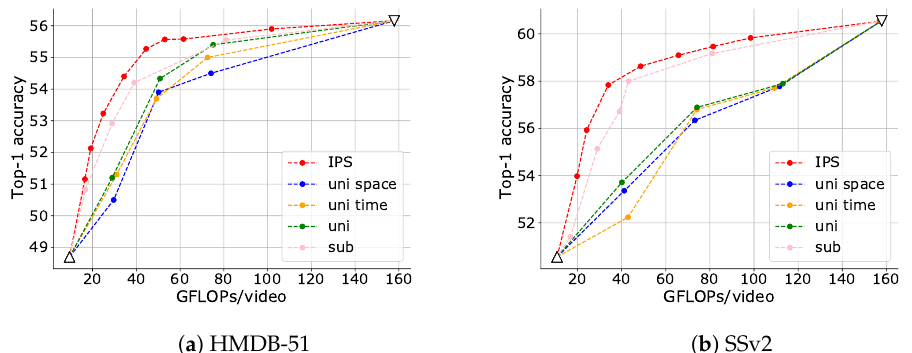
Figure 9. Comparisons of trade-offs between top-1 accuracy and inference cost adjusted via IPS and the baselines. The data point with the highest FLOPs for each setting is obtained when no input reduction is performed (upper bound), and the data point with the lowest FLOPs is obtained when only I-frames are input (lower bound). In these comparisons, the upper and lower bounds are the same for all settings, and they are plotted as a white-filled inverted triangle and a triangle, respectively.